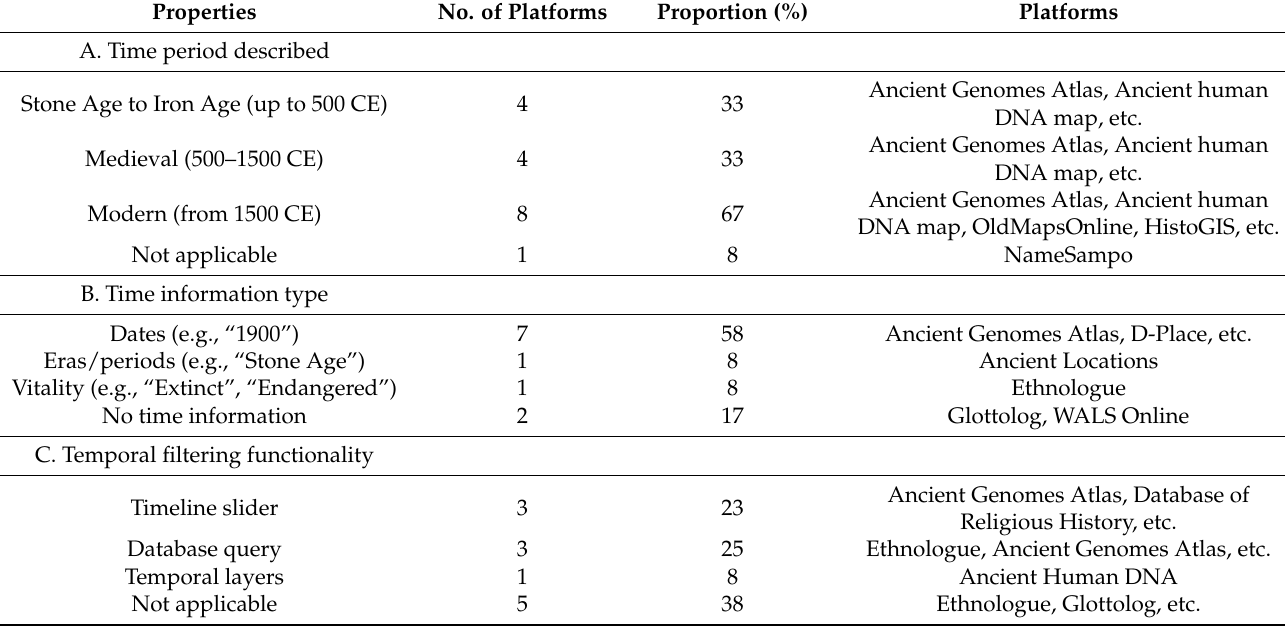
Table 4. (A) Time periods described, (B) time information type, and (C) time filtering type in our review of historical spatial data platforms. Note that the classification is non-exclusive; platforms can belong to multiple